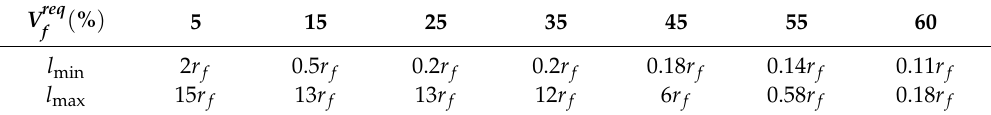
in the RSE algorithm. f